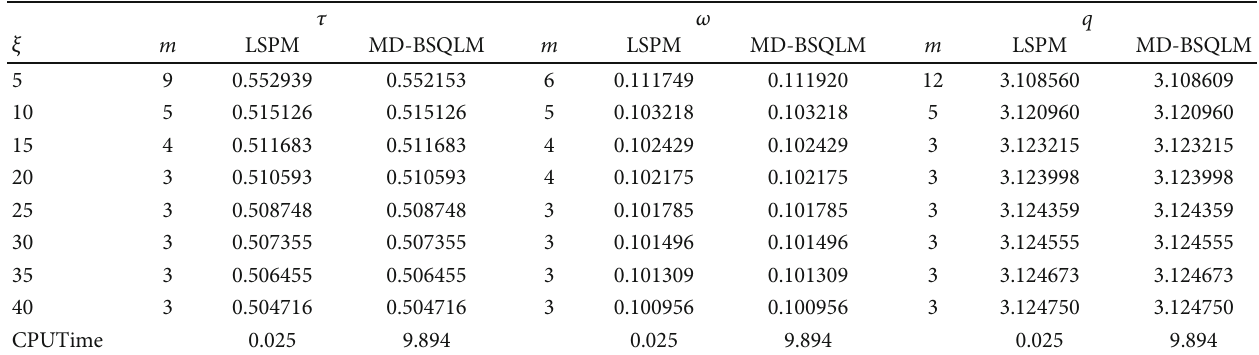
= 0 : 6 , and He = 0 : 2 . R